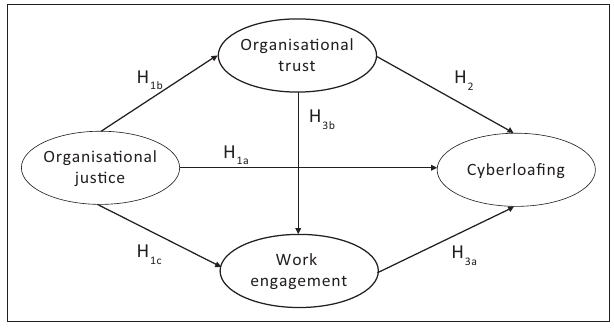
FIGURE 1: Hypothesised research